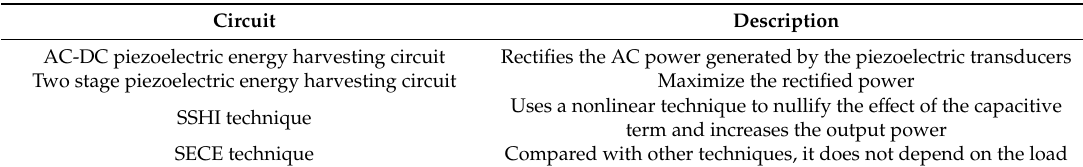
Table 6. Summary of the most popular circuits used in piezoelectric energy harvesting.